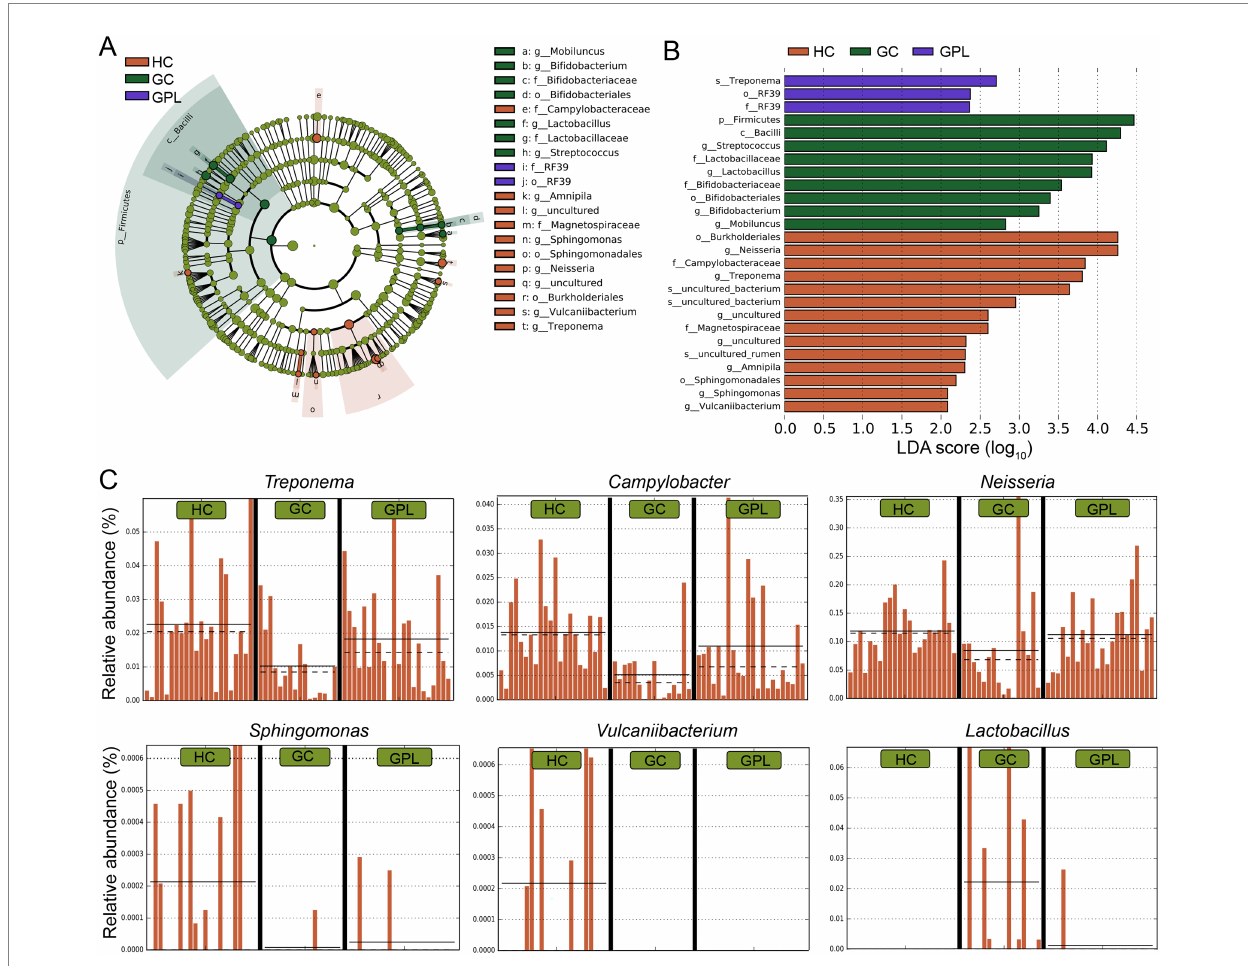
FIGURE 3 LEfSe analysis of taxonomy with significant differences in abundance among groups. (A) Evolutionary branching diagram. The circles radiating from the inside to the outside represent taxonomic levels from the phylum to the genus. Each small circle at different taxonomic levels represents a taxon at that level, and the diameter size of the small circles is proportional to the relative abundance size; species without significant differences are uniformly colored in chartreuse, and the difference species Biomarker follows the group for coloring, red nodes indicate microbial taxa that play an important role in the HC group, green nodes indicate microbial taxa that play an important role in the GC group, purple nodes indicate microbial taxa that play an important role in the GPL group. The names of the species indicated by letters in the figure are shown in the legend on the right. (B) Histogram of LDA value, taxon with significantly different abundances in different groups are shown, and the length of the bar graph represents the effect size of the significantly. (C) Comparison of the abundance of biomarkers in each sample among HC, GPL and GC groups. HC, healthy control; GPL, gastric precancerous lesions; GC, gastric